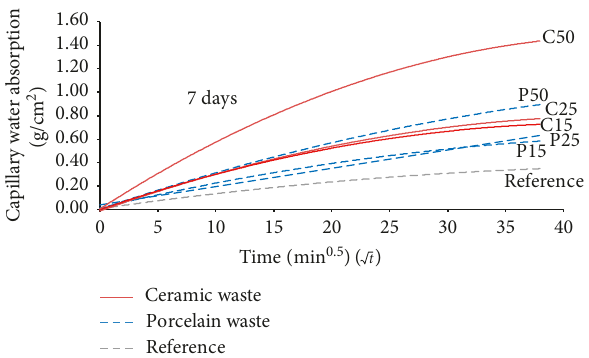
Figure 12: Capillary water absorption results.